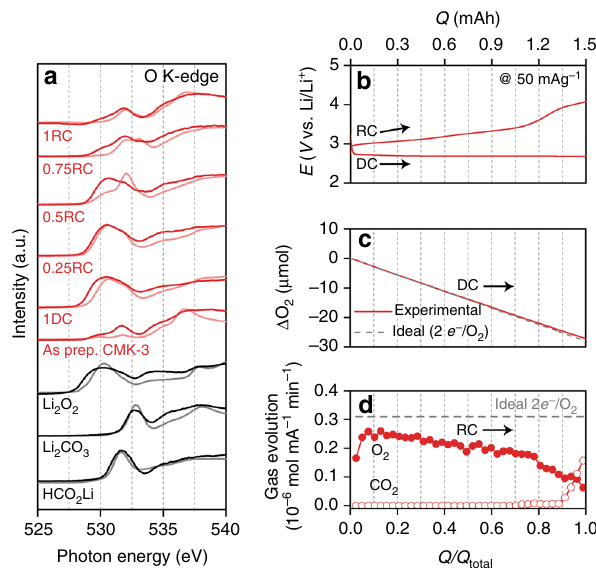
Fig. 3 Monitoring DC and RC processes. a O K-edge XANES spectra for CMK-3 electrode (red) at different depths of DC/RC and standard references of Li 2 O 2 , Li 2 CO 3 , and HCO 2 Li (black). The dark and light colors indicate bulk-sensitive partial fl uorescence yield (PFY) and surface- sensitive total electron yield (TEY) modes, respectively. The different DC and RC states are denoted from Q/Q total at a fi xed Q total of 1.0 mAh and a current rate of 50 mA g – 1 carbon . b – d In situ pressure and gas analyses during DC and RC, respectively, using online electrochemical mass spectrometry (OEMS): b DC – RC curve at a current rate of 50 mA g − 1 and a capacity of 1.5 mAh. c The gas-pressure decrease during DC (overall 2.06 e ─ / O 2 ). d O 2 gas (overall 3.17 e ─ /O 2 ) and CO 2 gas (over 0.9RC) evolution with the corresponding RC. The horizontal dashed line represents the ideal 2 e ─ / O